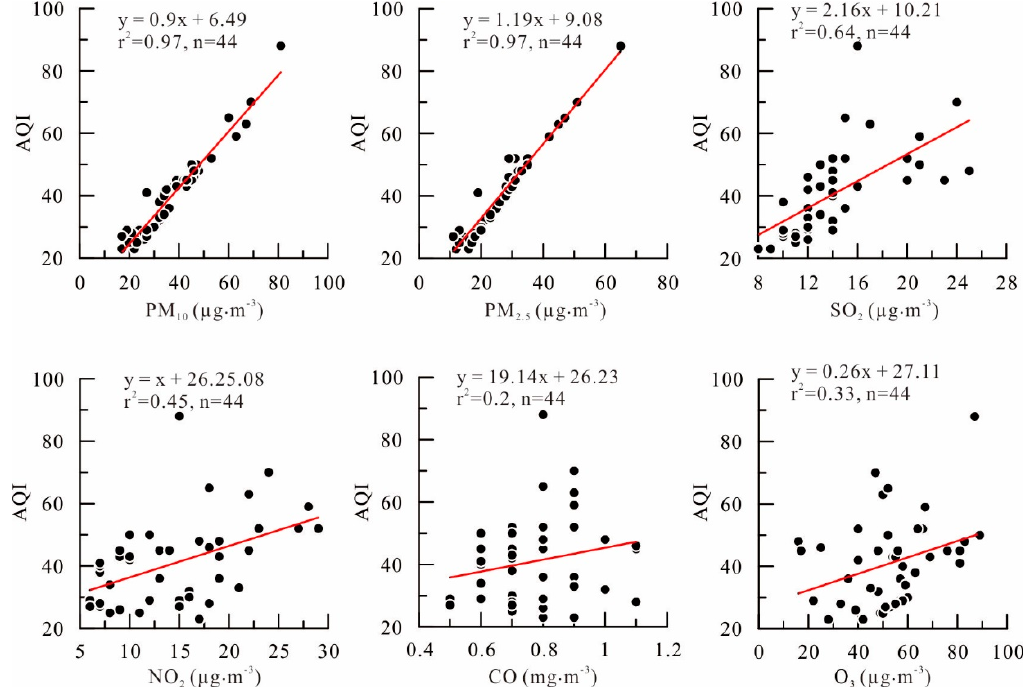
Figure 4. The correlation between Air Quality Index (AQI) and the daily average concentrations of PM 10 , PM 2.5 , SO 2 , NO 2 , CO, and O 3.